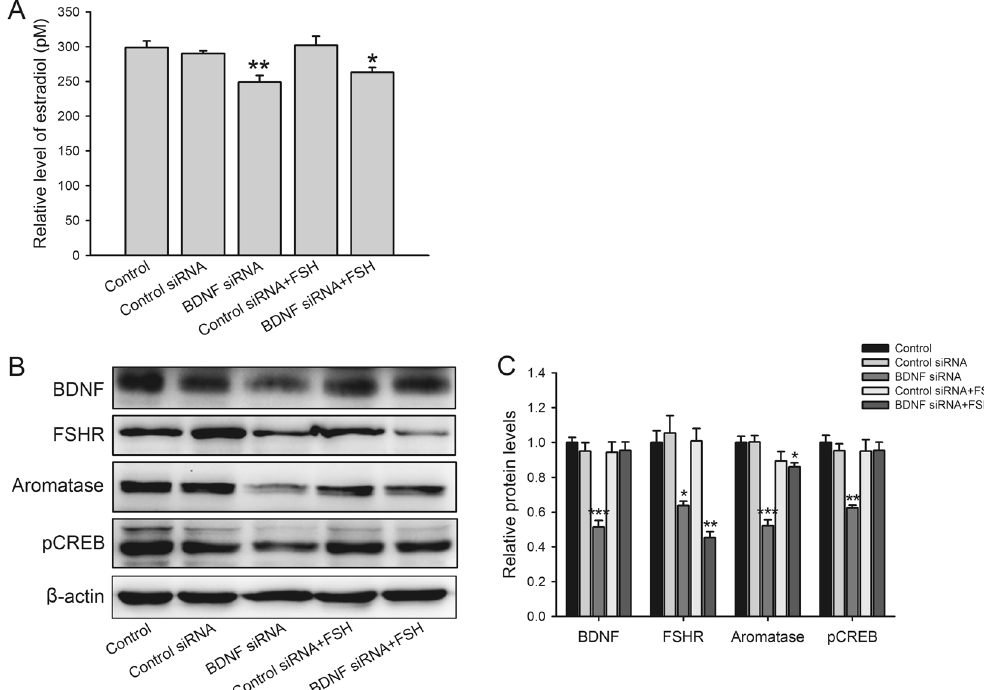
Figure 9. Effects of BDNF siRNA and FSH treatment on estradiol secretion, and FSHR, aromatase and phosphorylated CREB levels. ( A ) Production and secretion of estradiol was detected by chemiluminescent immunoassay system. ( B ) Western blotting measured the protein levels of BDNF, FSHR, aromatase and pCREB (Ser133) in KGN cells transfected with BDNF siRNA. ( C ) Relative protein levels in ( B ) are expressed as fold changes over control. * P < 0.05, ** P < 0.01 and *** P < 0.001 versus control